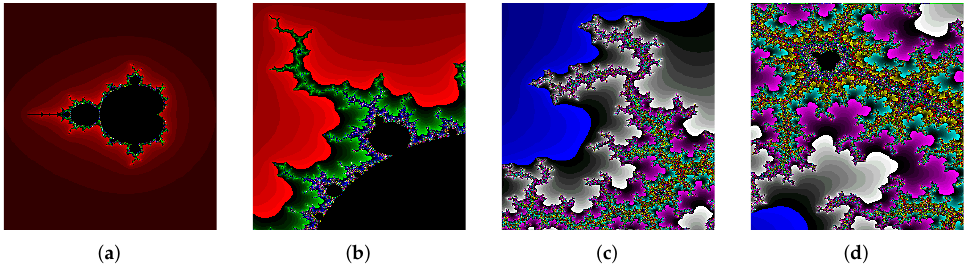
Figure 20. ( a – d ) Snaps of an animated screensaver exploring details of the Mandelbrot set.